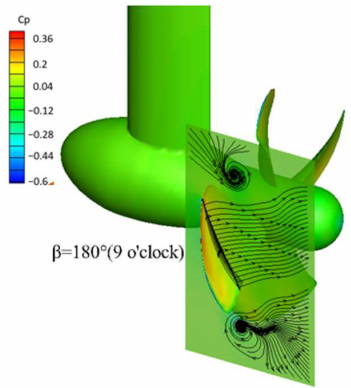
Figure 20. r/R = 0.7 cross-section